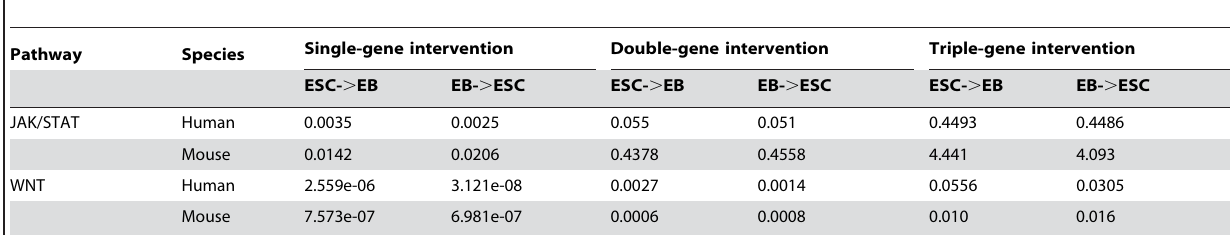
Table 3. Sums of probabilities of network transition between ESC and EB states under different transcriptional interventions conducted on JAK/STAT and WNT pathways.